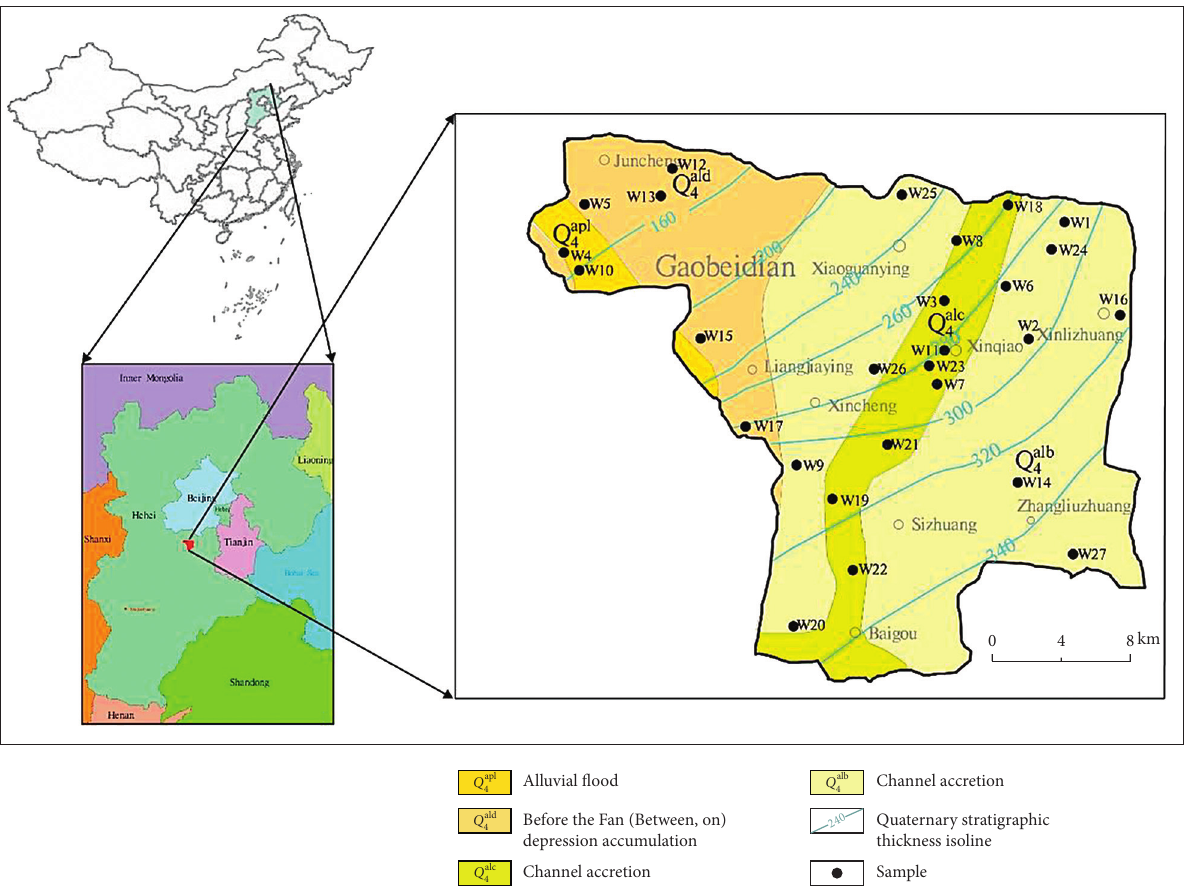
Figure 1: Location of the study area and monitoring